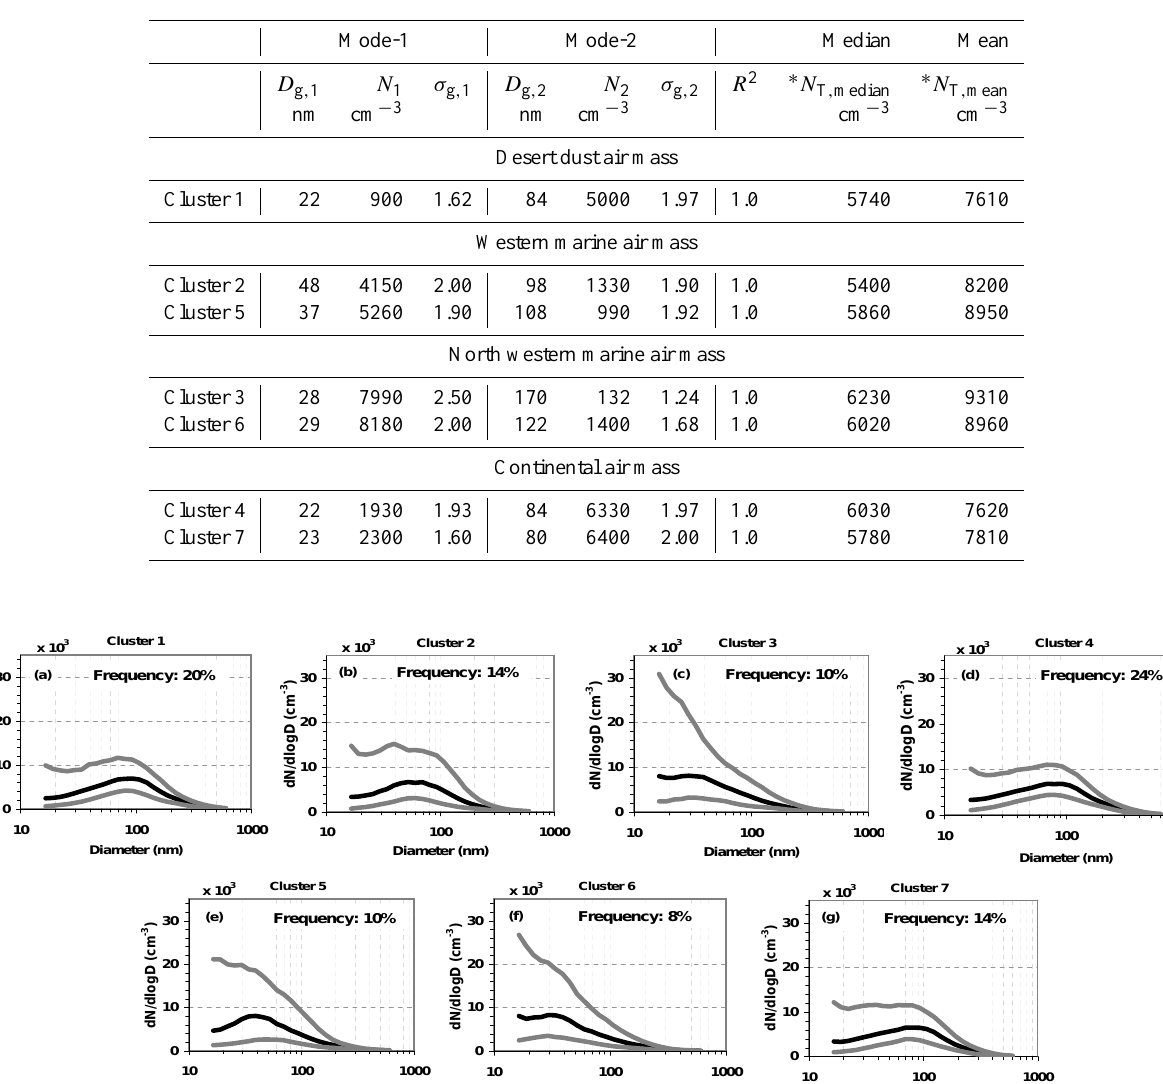
Table 4. Median number size distribution log-normal parameters of each cluster. The D g ,i , N i and σ I represent the geometric diameter, median number concentration and geometric standard deviation, respectively. The correlation coefficient ( R ) between observed and fitted size distributions is also shown. ∗ The median and mean total number concentrations ( N T , median and N T , mean ) are calculated from the measured values instead of the fitted ones.